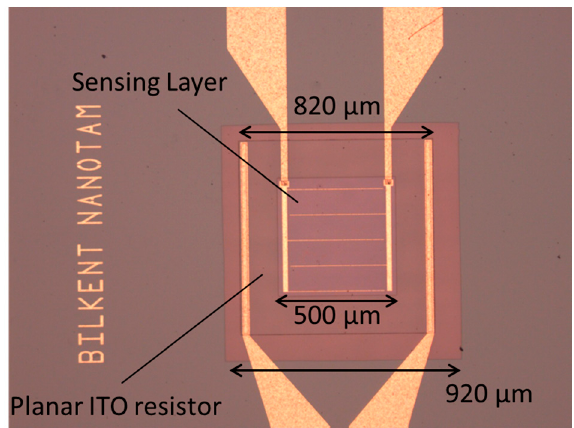
Figure 2. Fabricated sensor’s optical microscope photograph.